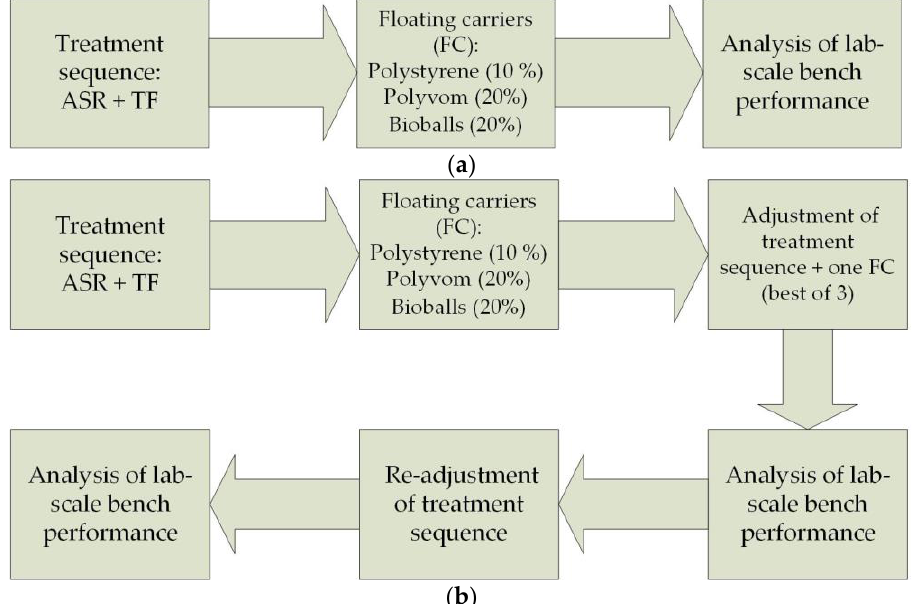
Figure 6. Research sequence: ( a ) initial research procedure: ( b ) final research procedure